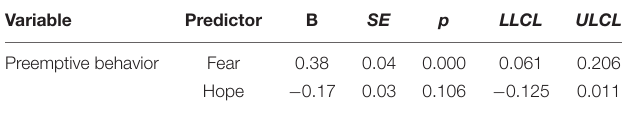
TABLE 3 | The logistic regression model of emotion on preemptive behavior.